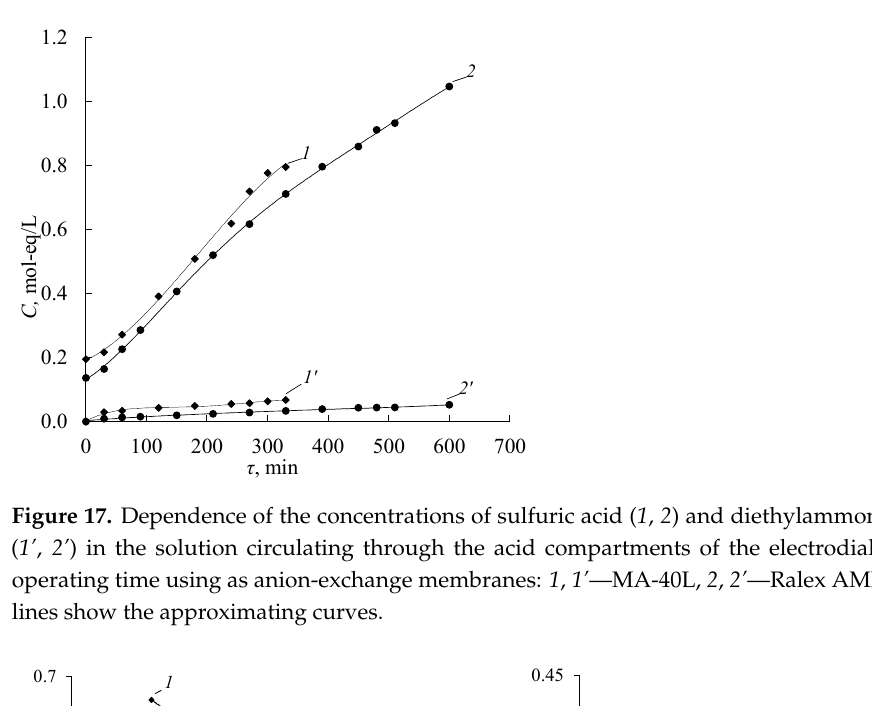
Figure 16. Dependence of the concentrations diethylamine ( 1 , 2 ) and diethylammonium sulfate ( 1’ ,